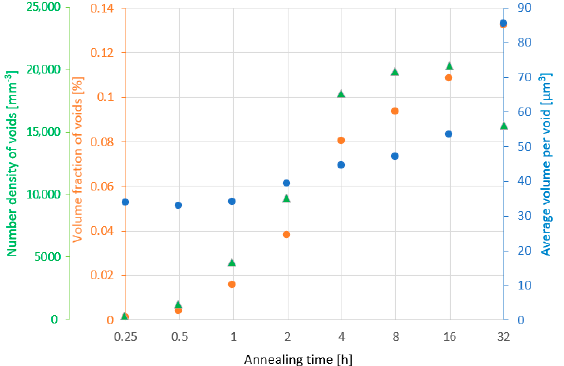
Figure 7. Summary of main features of Kirkendall voids formed during isothermal annealing at 450 ◦ C between 0.25 h and 32